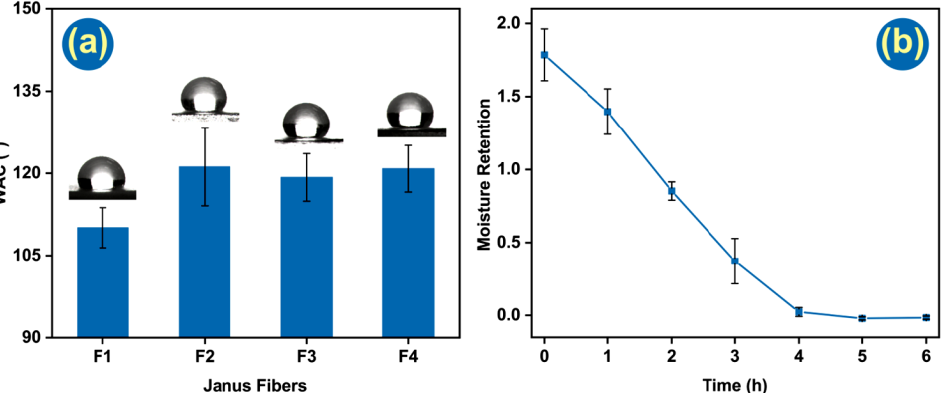
Figure 7. ( a ) Water contact angle tests of four kinds of Janus fiber; ( b ) moisture retention test for F1.